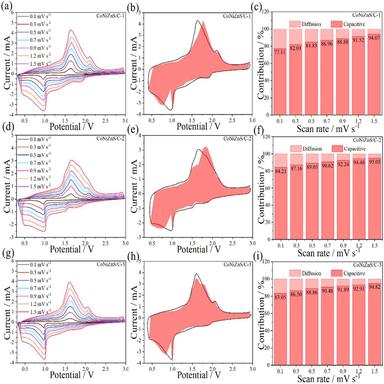
Calibrated CV curves of (a) CoNiZnS/C-1, (d) CoNiZnS/C-2, and (g) CoNiZnS/C-3 based anodes at different scanning rates from 0.1 to 1.5 mV s1 ; The capacitive contributions of (b) CoNiZnS/C-1, (e) CoNiZnS/C-2, and (h) CoNiZnS/C-3 materials in comparison to the total current at the scan rate of 1.5 mV s1 ; The capacitive contribution ration at different sweep rates from 0.1 to 1.5 mV s1 of (c) CoNiZnS/C-1, (f) CoNiZnS/C-2, and (i) CoNiZnS/C-3 materials.